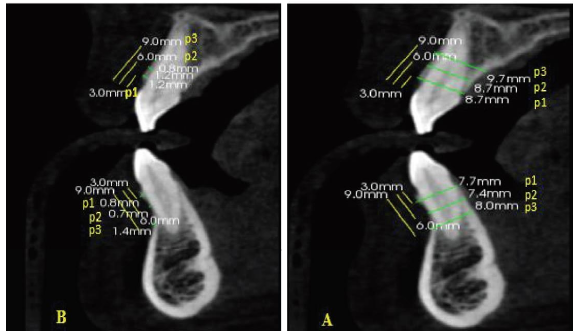
Figure 2: Representative images showing (a) the measurements of alveolar bone width. (b) Measurements of facial cortical bone width both measured for the upper and lower jaws at three points ((P1: 3mm; P2: 6mm; P3: 9mm) from the cementoenamel junction).